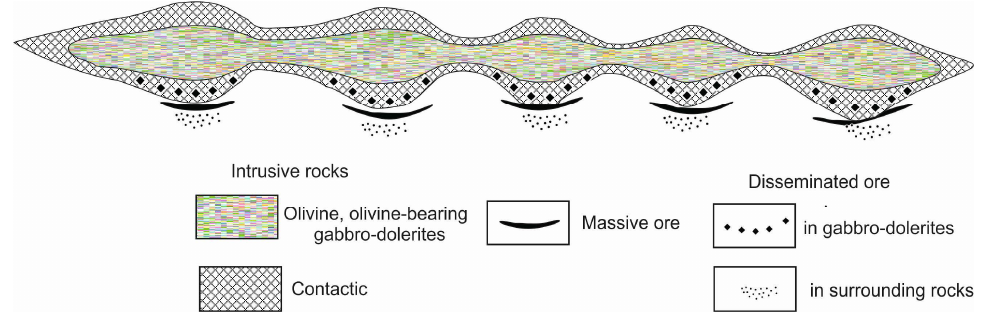
Figure 16. Model of positions of disseminated and massive ore in the North-Western branch of the Talnakh intrusion (after Likhachev [8], with changes).